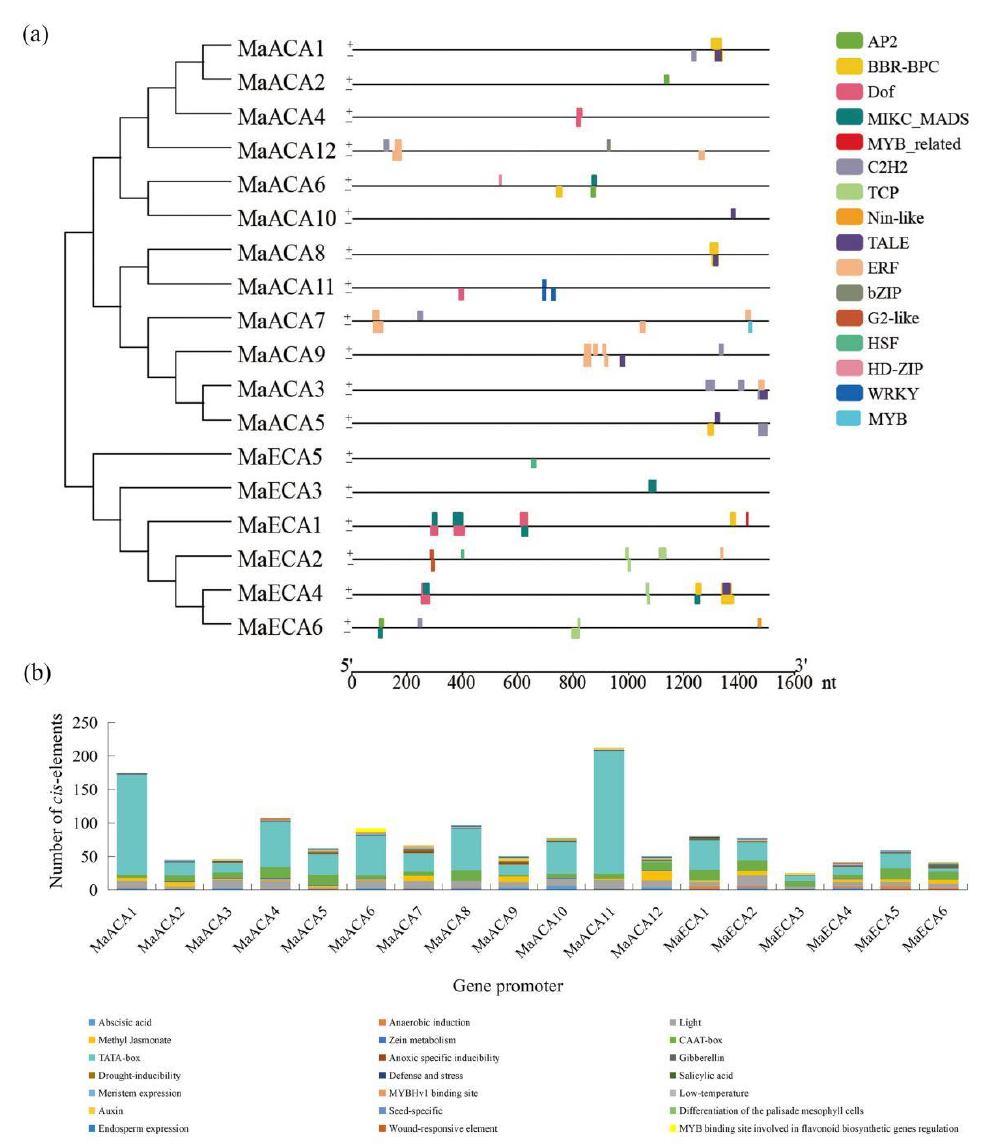
Figure 4. The predicted transcription factor binding sites ( a ) and cis -acting elements ( b ) on the pro- moters of banana Ca 2+ -ATPase genes.